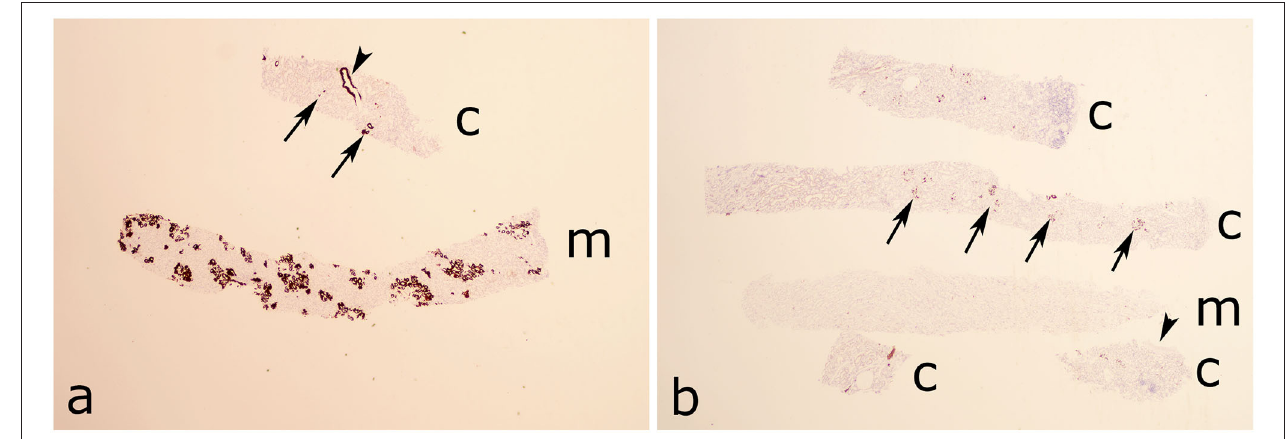
FIGURE 3 | Overview micrograph with serum amyloid A (SAA) staining of the two biopsies. (a) In case 1 the amyloid is mainly localized in the medulla and focally in glomeruli and vessels. Cortex is sparse. (b) In case 2 the amyloid is focally distributed in glomeruli and negative in an artery and the interstitium. Arrows indicates glomeruli, arrowheads arteries. c, cortex; m,